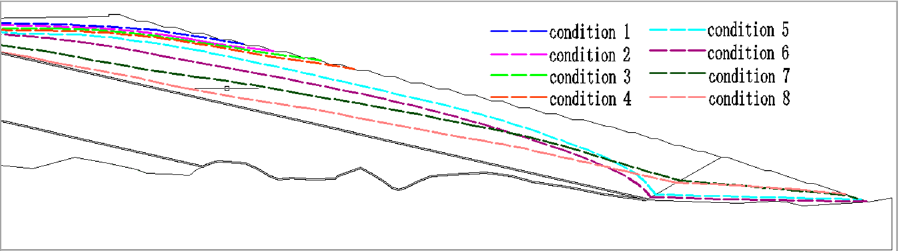
Figure 7. Dam phreatic line distribution under different conditions.